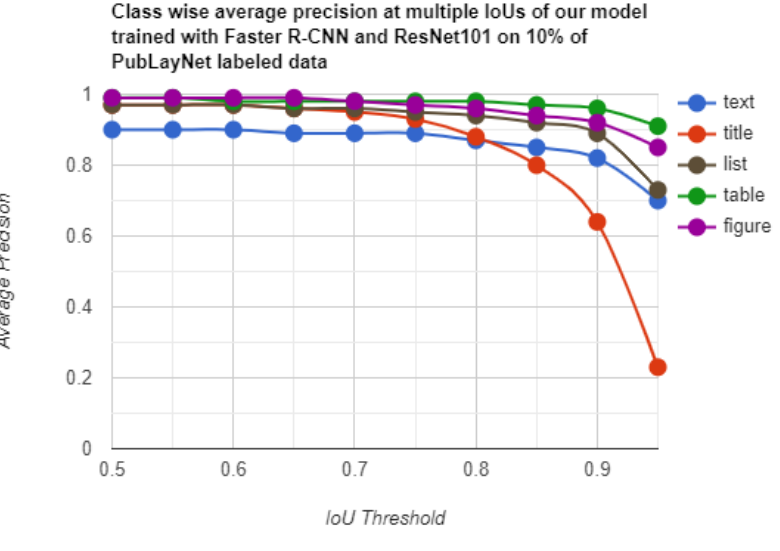
Figure 6. A visual representation of Precision, Recall and F1-Score at multiple IoUs. Our model is trained on 10% PubLayNet labeled data with Faster R-CNN and ResNet101.